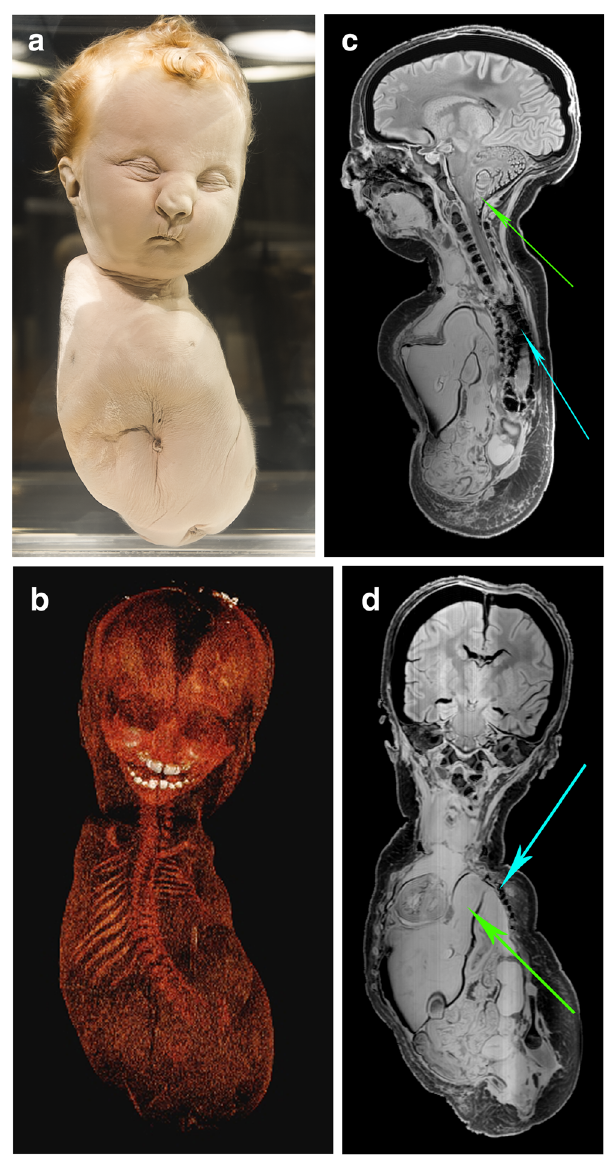
Fig. 7 a Photograph of the full-term fetus of case 4. b Three-dimensional reconstructed skeleton based on the CT data. Although there was severely diminished bone calcification, CT images visualised small pelvic bones, partial absence of the sacral bone and a thoracolumbar convex shaped curvature. The scapulae and clavicles were normally developed with ab- sence of the humeral, ulnar and radial bones including the hands. In addi- tion, the femora, tibial and fibular bones including the feet were absent. c Sagittal T1-weighted MR image showed an Arnold-Chiari malformation ( green arrow ) and distorted vertebral column ( turquoise arrow ). d Coronal T1-weighted MR image showed a severe diaphragmatic hernia ( green arrow )whichdeviatedtheheartcompletelytotheright lateralthoracicwall. The left pleural cavity was almost entirely occupied by the liver, stomach, spleen and left adrenal gland, the left lung was merely noticeable. Moreover, a distortion of the left ribs was seen ( turquoise arrow